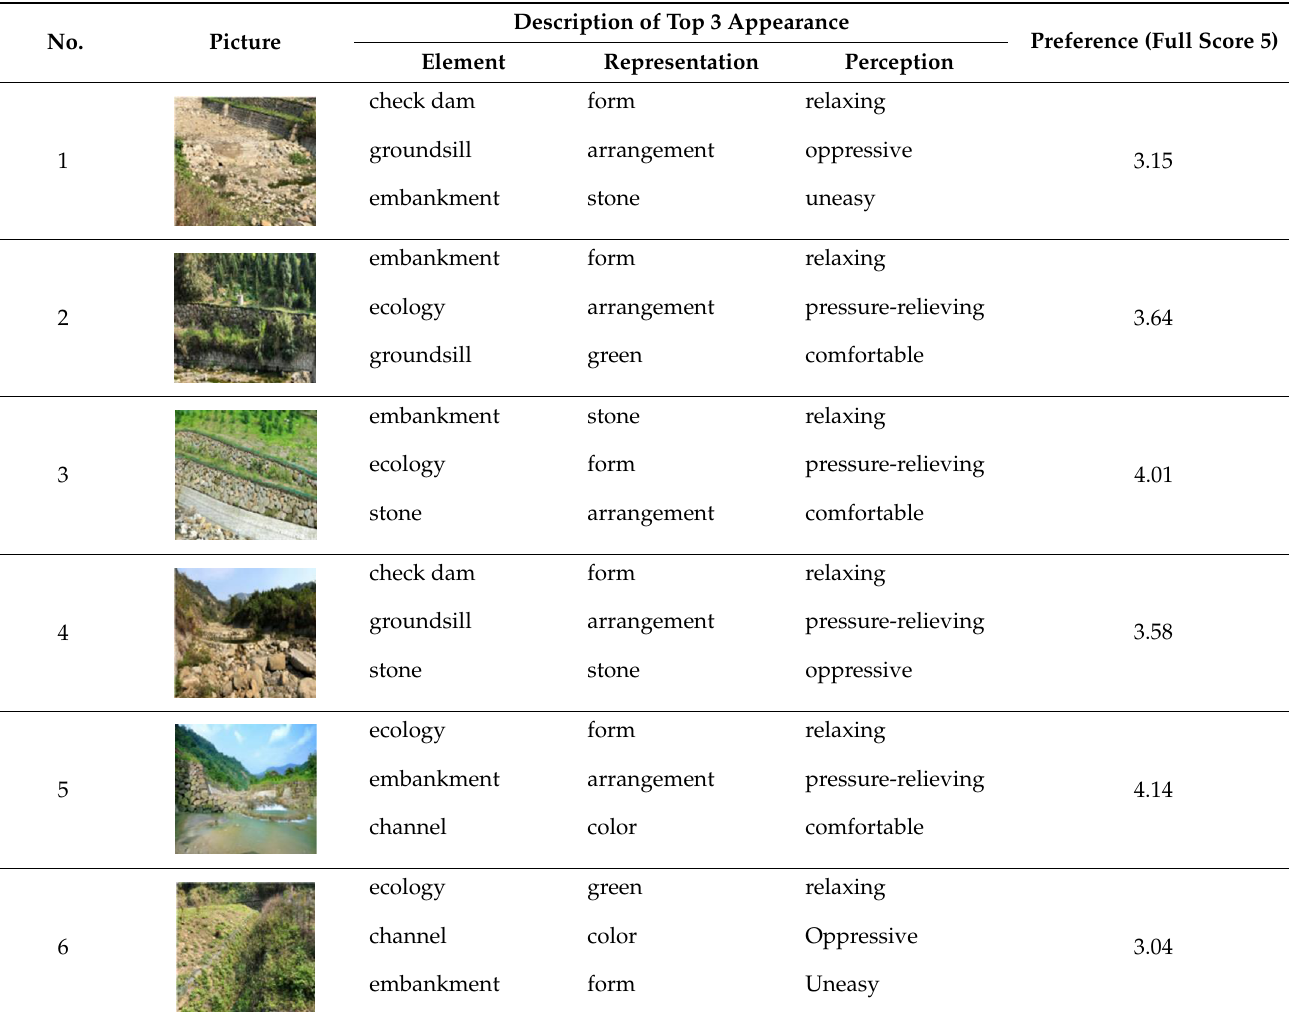
Table 1. CEM results of the “Upstream Renovation Project of Toubiankeng Stream in Zhongpu”. No. Picture